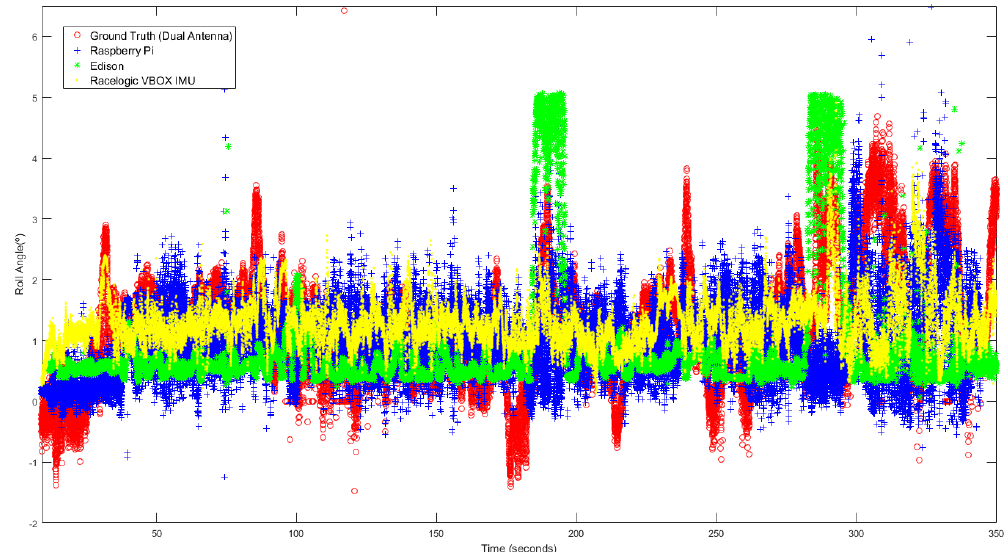
Figure 13. ANN estimated + ground truth roll angle for general circulation. Table 7. Test 3. Errors of estimated roll angle on Raspberry Pi 3 Model B and Intel Edison compared with the measured roll from VBOX (ground truth).